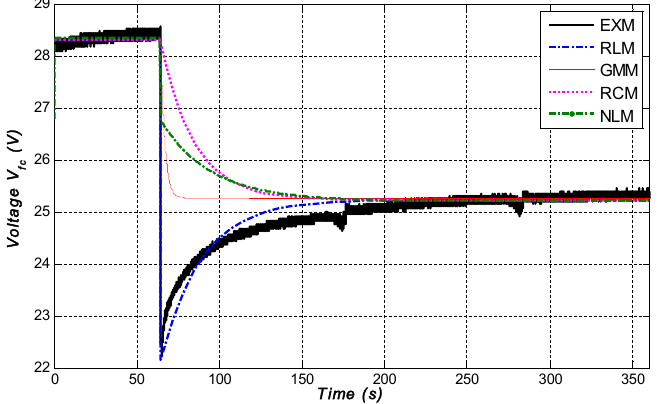
Figure 13. Dynamic behaviour of simulated models compared to the experiments.